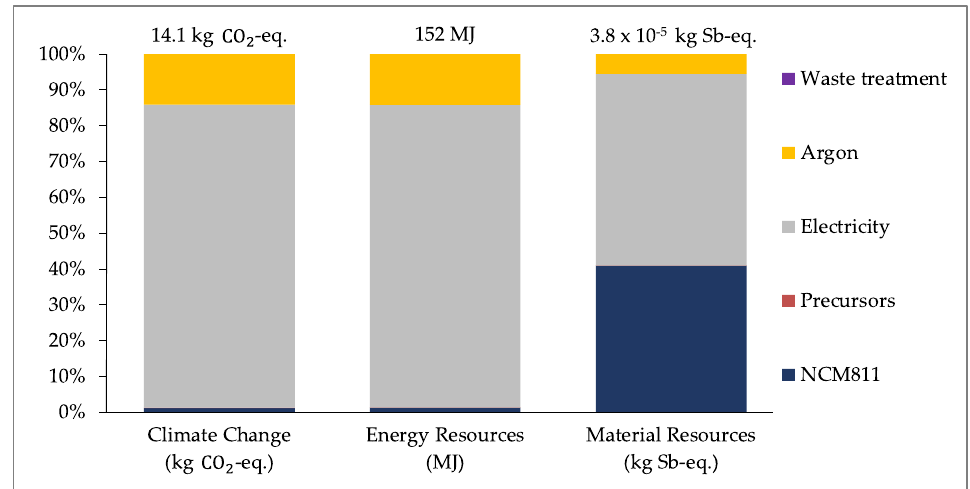
Figure 6. LCIA Results for the ALD Process with a Reference Flow of 7 g of Input NCM811.